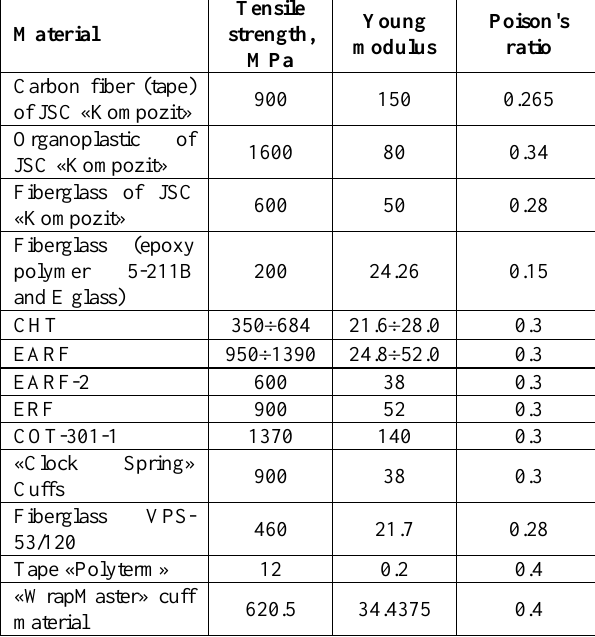
Table 2. Specifications of